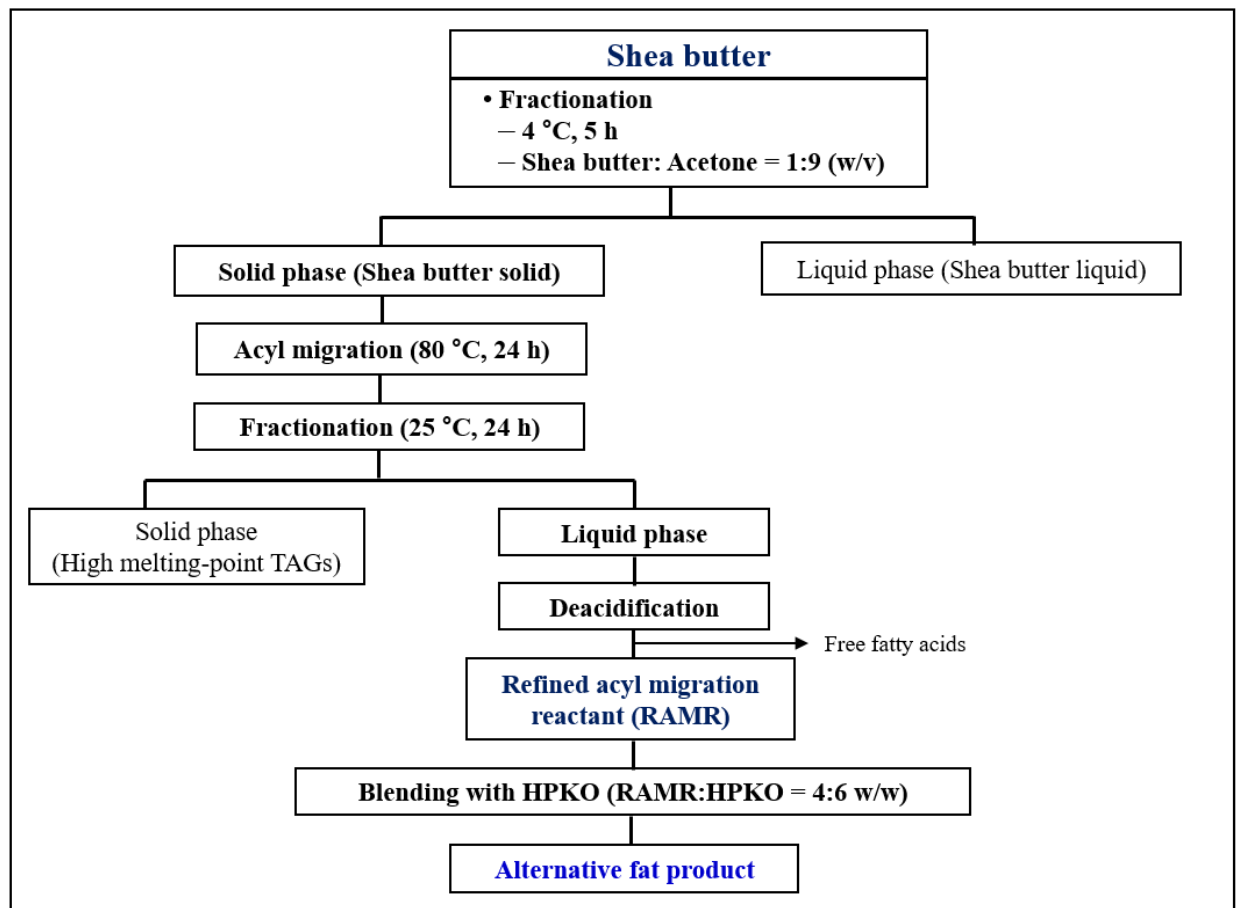
Figure 1. Preparation scheme of the alternative fat for whipping cream. The positional TAG isomer separation results of shea butter, shea butter liquid and solid fractions, and acyl-migrated shea butter solids (0, 3, 24, and 100 h) analyzed using a normal-phase HPLC-evaporative light-scattering detector (ELSD) with an Ag column are summarized in Table 1. Silver-ion HPLC provides regioisomer separation for TAG molecules according to the number, configuration, and position of double bonds in fatty acids [13]. Using this method, the degree of acyl migration of shea butter solid used as a substrate was compared according to the enzymatic reaction time (0, 3, 24, and 100 h). The shea butter consisted of 67.8 area% saturated-unsaturated-saturated (SUS) TAGs and 31.3 area% saturated-unsaturated-unsaturated (SUU) TAGs (Table 1), similar to the results of a previous study [14]. Shea butter solid obtained after acetone-fractionation at 4 ◦ C showed that symmetric TAG content of SUS was 92.5 area% and asymmetric TAG content of SUU was drastically reduced to 6.9 area% from 31.3%. In the shea butter liquid fraction (Table 1), symmetric TAGs such as SUS were present only at 3.6 area%, and most of the asymmetric TAGs presented as SUU type (96.4